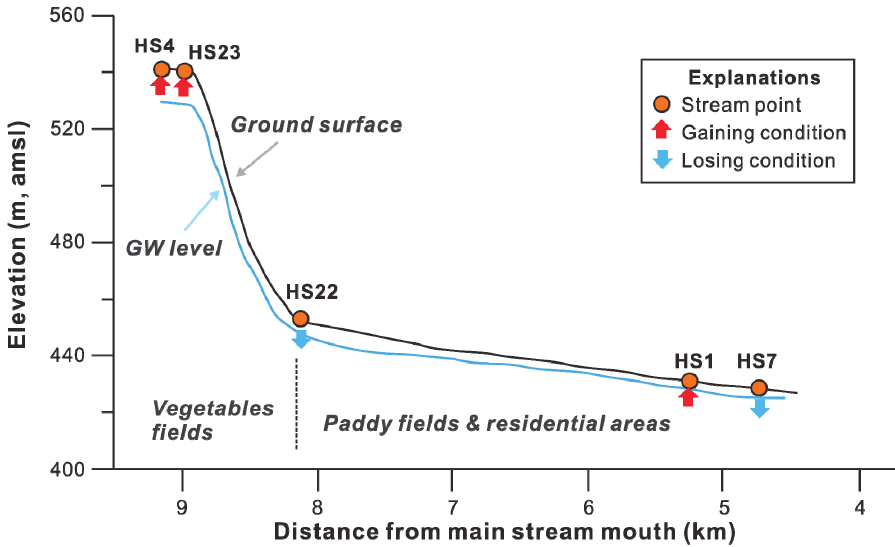
Figure 10. Schematic of stream conditions with topographic elevations and groundwater levels in the study area. Stream levels were lower than the ground surface elevations. The vertical exaggeration is approximately